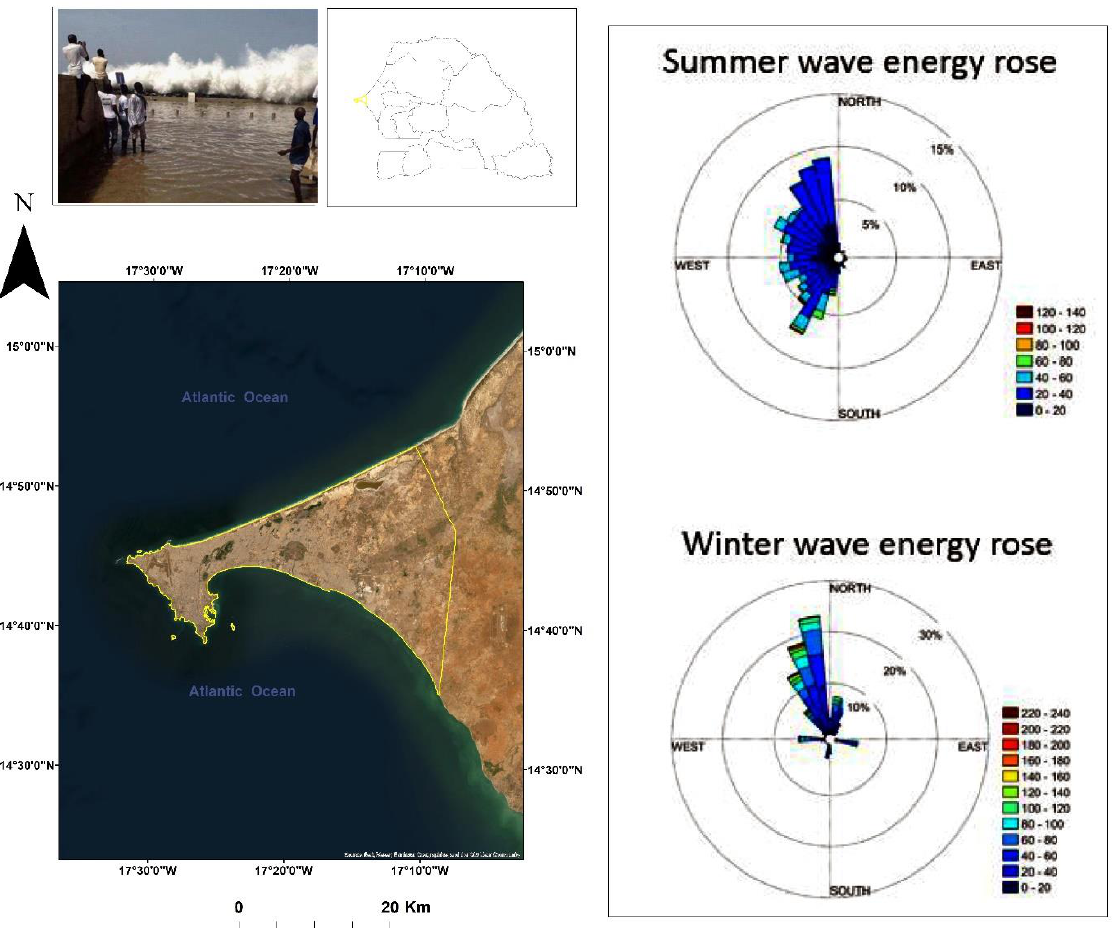
Figure 1. Location of Dakar [41] (latitude = 14.71°, longitude = – 17.46°), Senegal (West Africa). Left column roses show summer and winter months wave energy incoming directions.